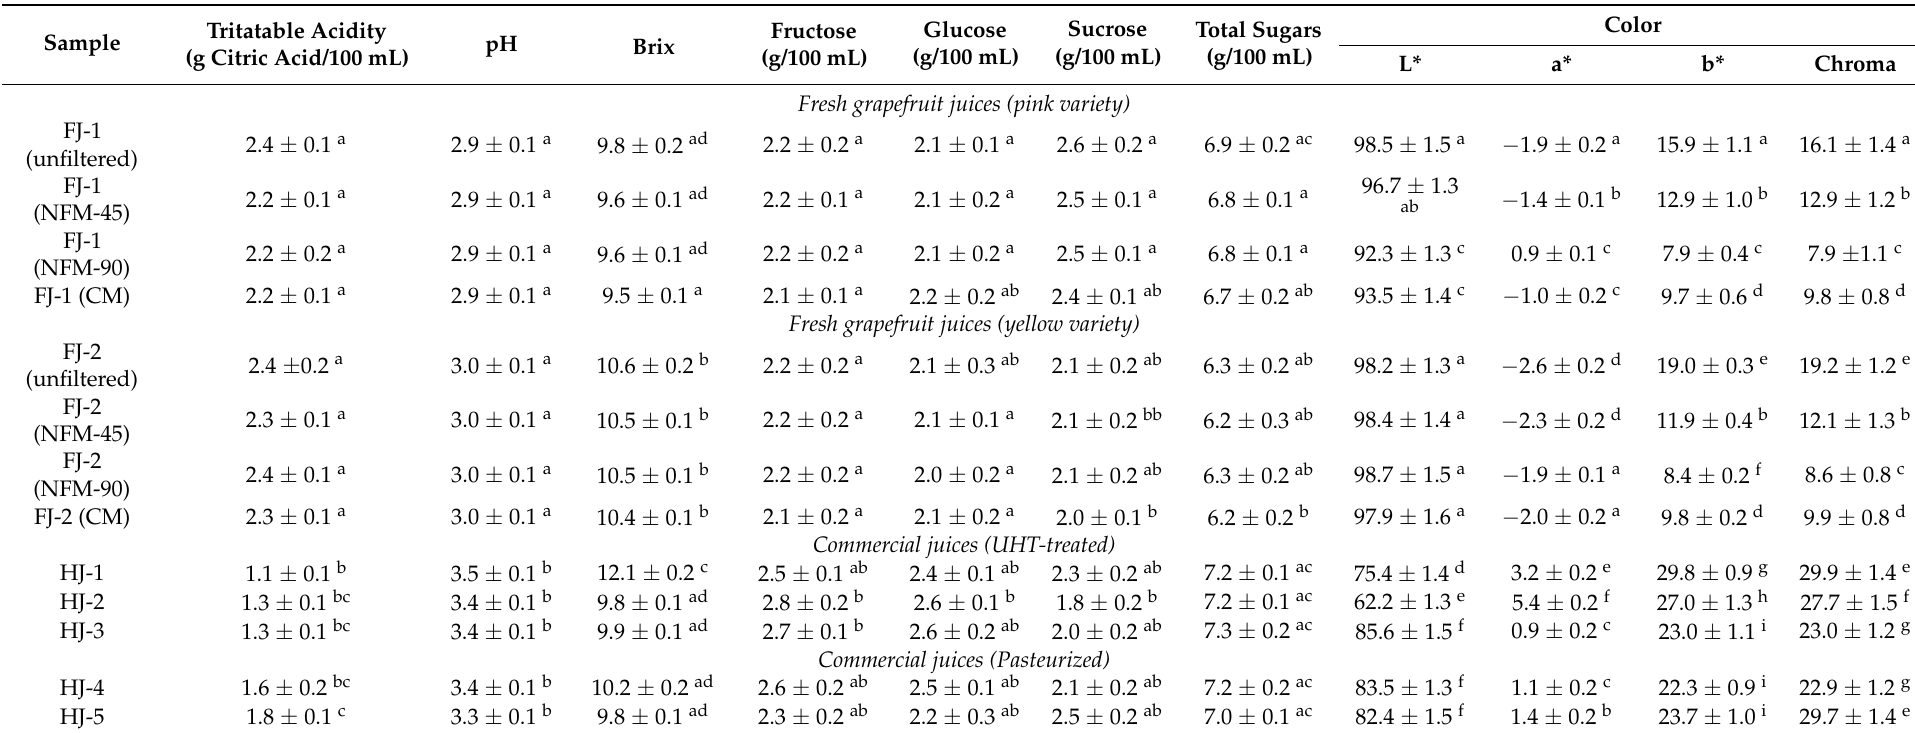
Table 1. Physicochemical parameters of grapefruit juices of two varieties, their filtrates obtained using nylon-6 nanofibrous membranes of different thicknesses (NFM-45, NFM-90), a nylon commercial membrane (CM), and five varieties of commercial (heat-treated) grapefruit